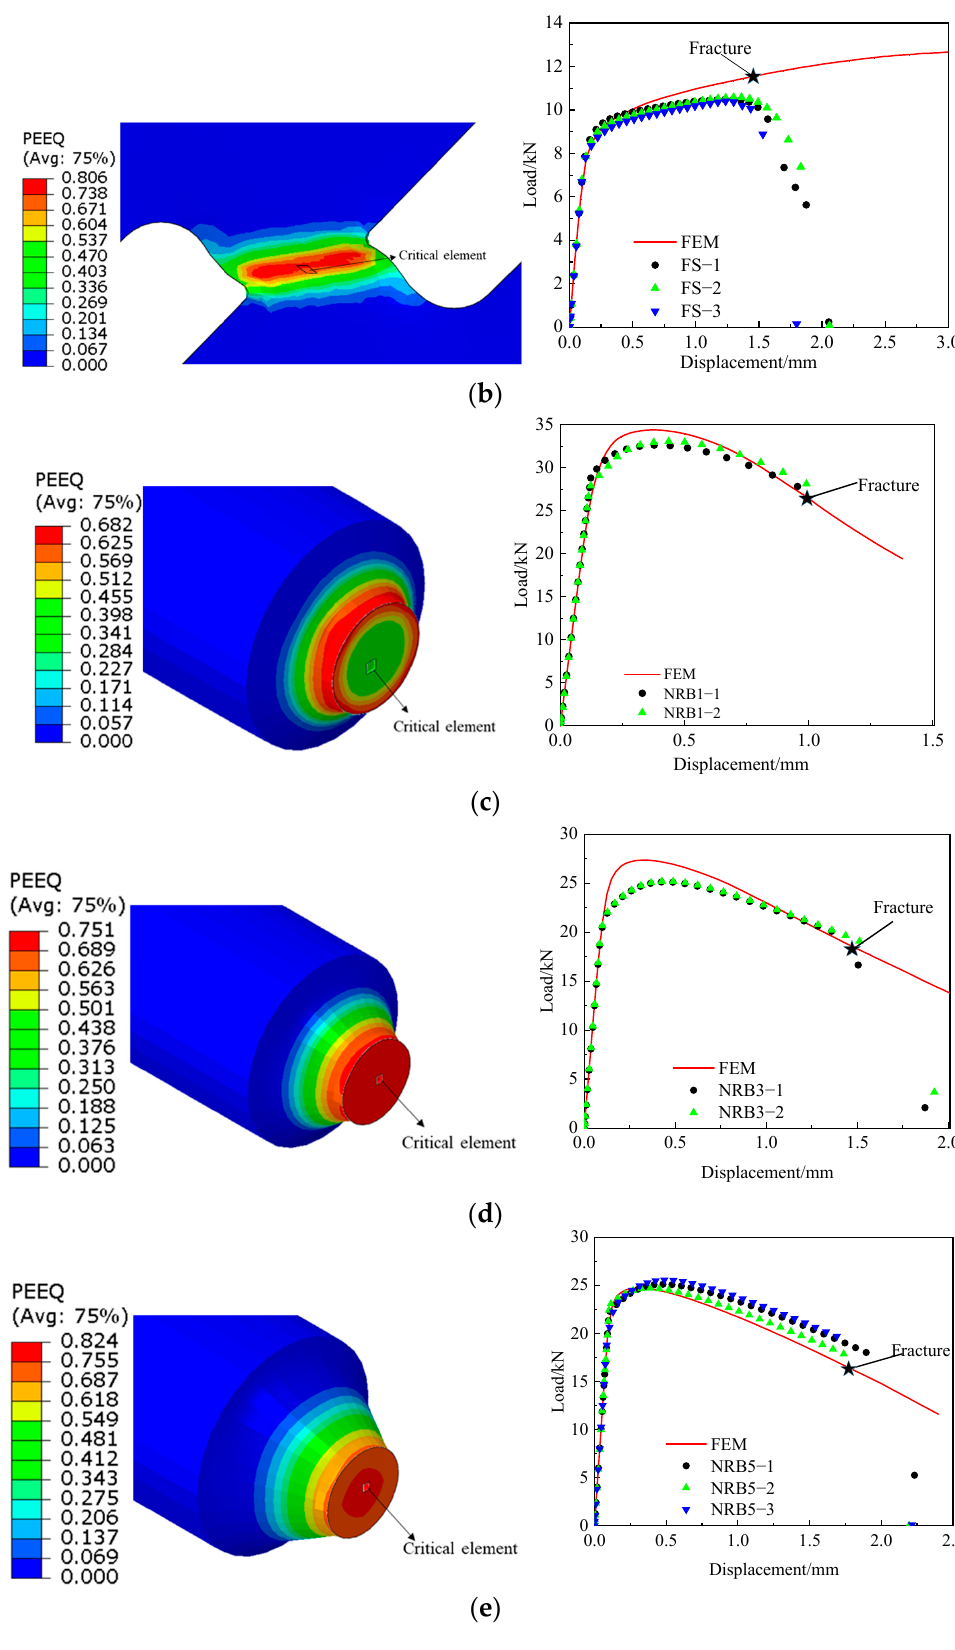
Figure 10. Determination of critical displacement: ( a ) CH6; ( b ) FS; ( c ) NRB1; ( d ) NRB3; ( e ) NRB5.